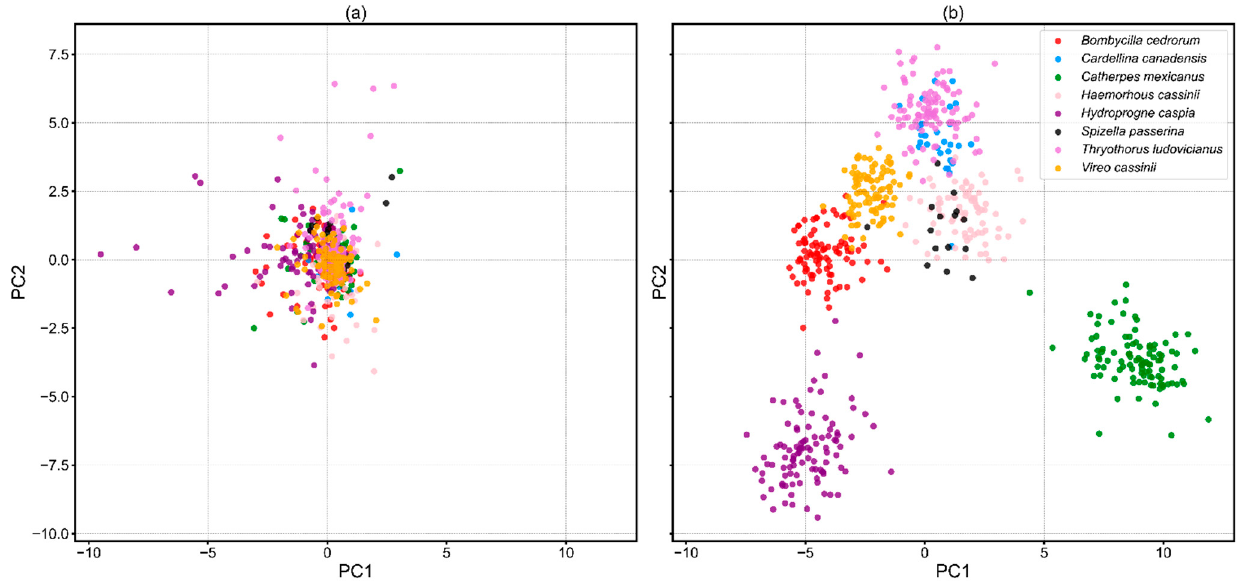
Animals 2022 , 12 , x FOR PEER REVIEW 16 of 20